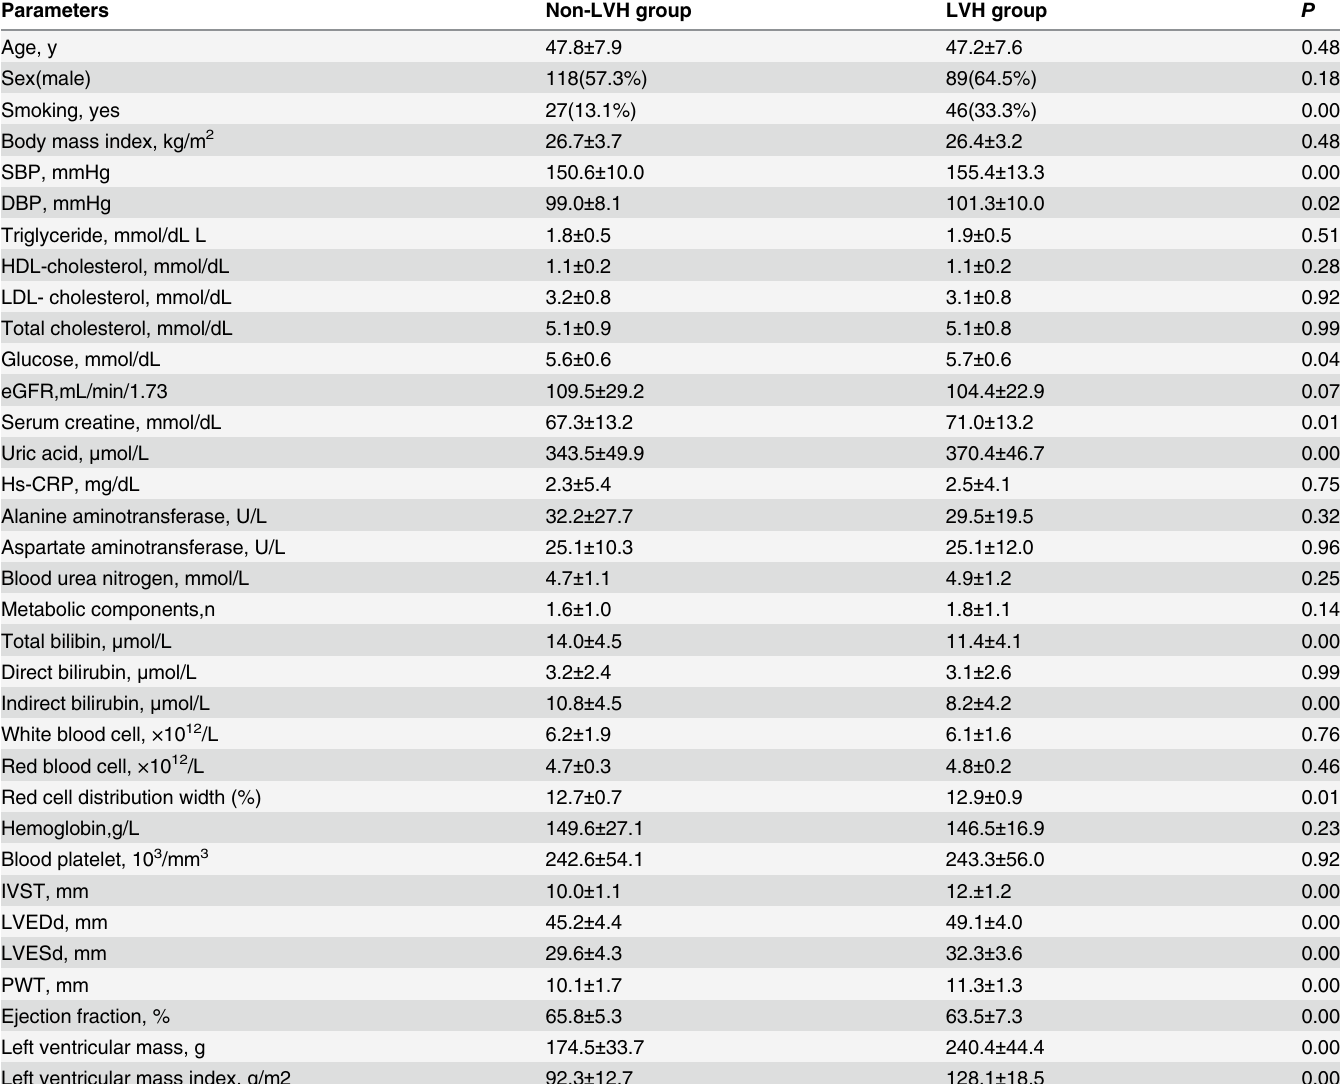
Table 1. Clinical characteristics of hypertension patients with and without